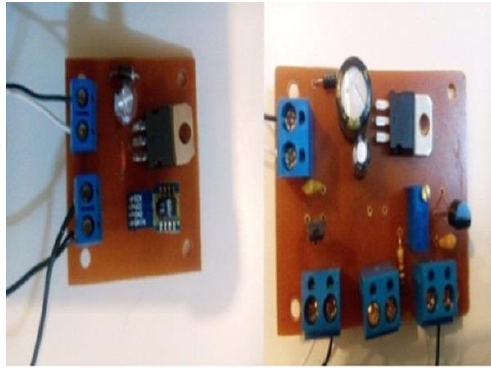
Figure 4. Final image of sensor nodes (analog nodes including LM35 and HIH4000 sensors on the right, and SHT node on the